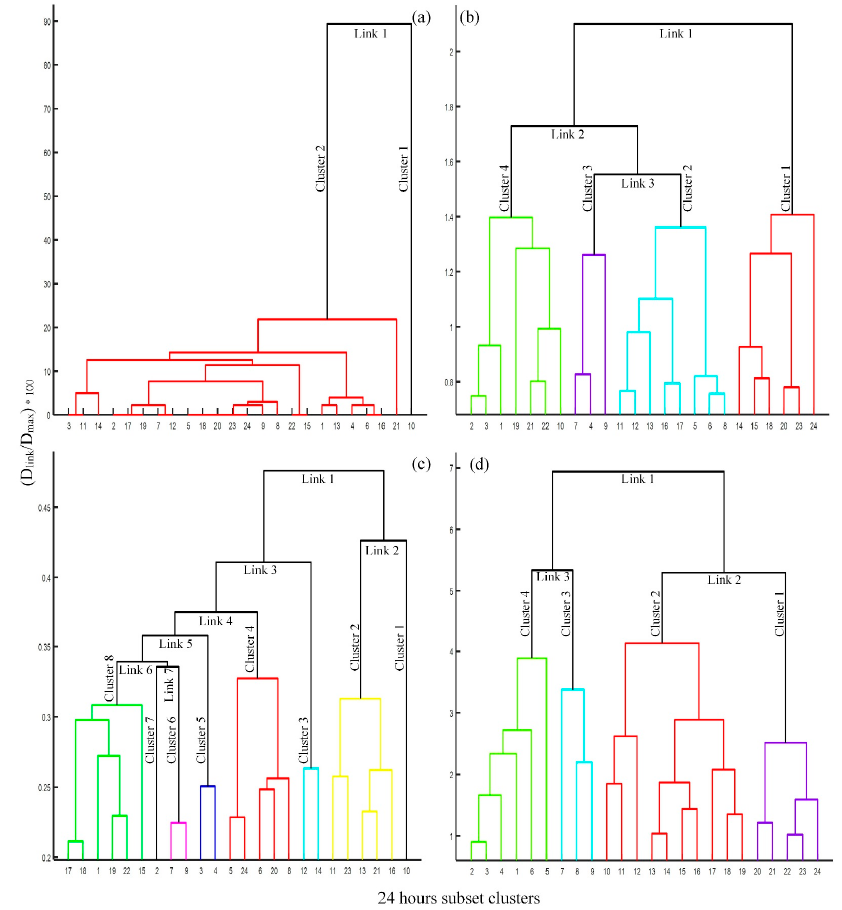
Figure 7. Dendrogram showing the hierarchical binary clusters of pdist time intervals of 24-h unsupervised static sampling site data collected via the ASM framework from Jungnangcheon stream during the three summer months and first fall month from 2014, 2015, and 2016. ( a ) Analysis of Physicochemical parameters (PcPs) obtained via the ASM during the experimental period; ( b ) nested stream temperature, in which red, blue, purple, and green lines represent the time of minimum, increased, moderate, and decline in stream water temperature, respectively; ( c ) dendrogram of DO, in which the black, yellow, blue, red and indigo, pink and black, and green line represent the time for the decreased, increased, minimum, maximum, initial increase in, and increased concentration level of stream respectively; ( d ) pH dendrogram, in which purple, blue, red, and green lines represent the drop, increase, peak and decrease in pH level.